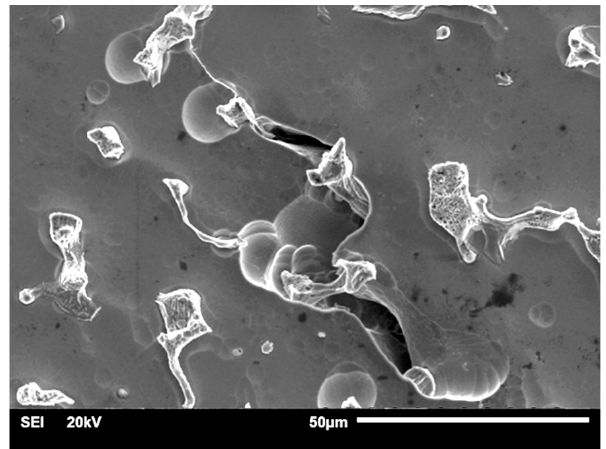
Figure 7. SEM-SE surface morphology of SM-Control-Corr (×1300).